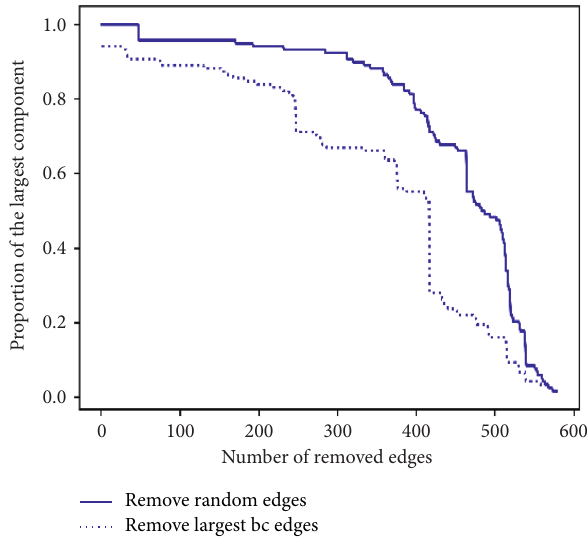
Figure 8: Robustness analysis under edge failure.